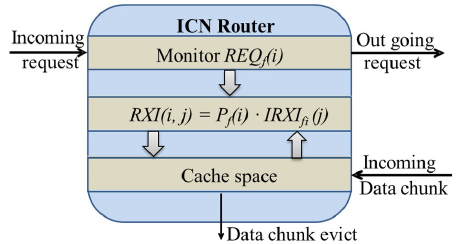
Figure 3. Monitor the request ratio REQ f ( i ) . REQ: Request ratio; RXI: Request expectation index; IRXI: Internal request expectation